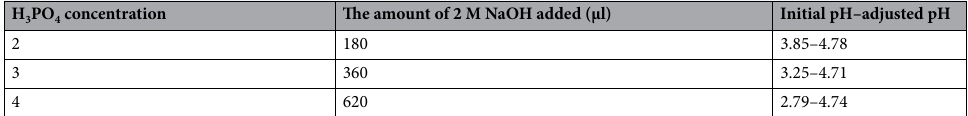
H 3 PO 4 concentration The amount of 2 M NaOH added